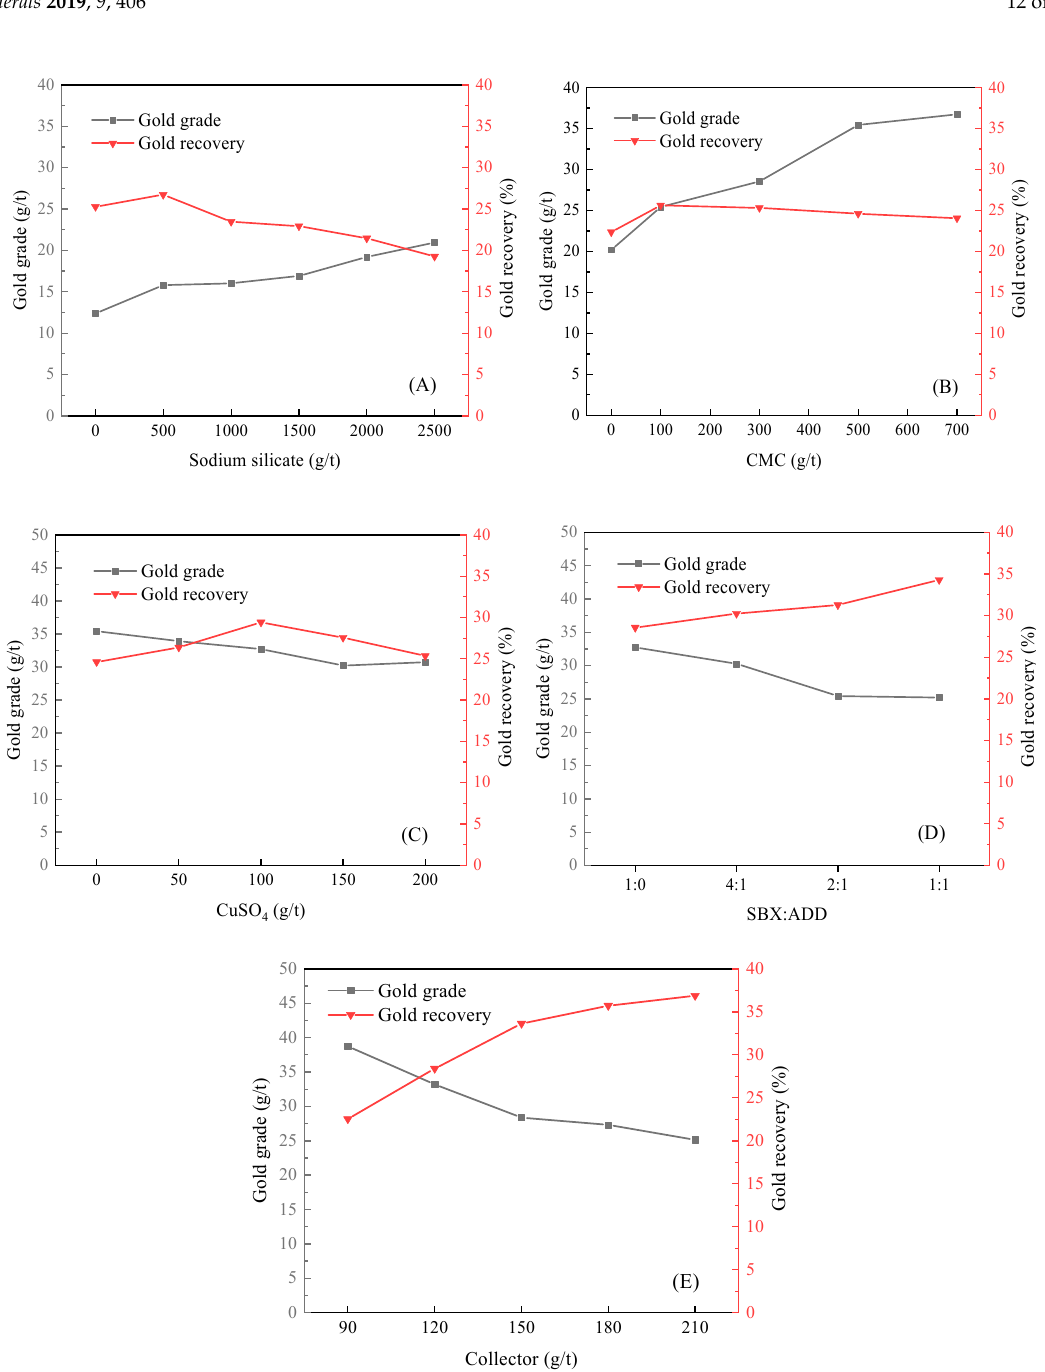
Figure 11. Effects of operating parameters on flotation recovery: ( A ) sodium silicate dosage, ( B ) CMC dosage, ( C ) CuSO 4 dosage, ( D ) the ratio of SBX and ADD, ( E ) collector dosage.